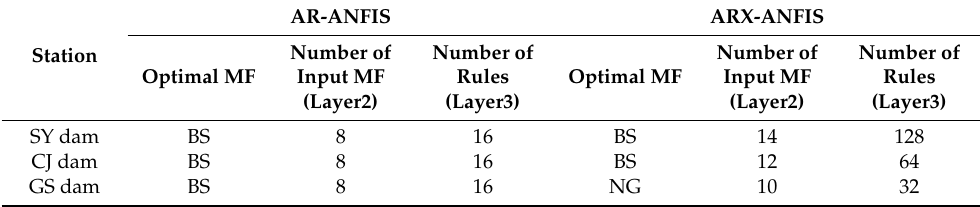
Figure 9. Correlation coefficients ( r ) and root mean square error (RMSE) of the AR-ANFIS and ARX-ANFIS models according to the MF in the validation period for the SY, CJ, and GS dams. The NS is normalized Gaussian MF and the BS is the Bell-shaped MF. The blue line is the r-value in the validation period and the red line is the RMSE in the validation period. Table 7. A number of input MFs and rules of the AR-ANFIS and ARX-ANFIS models for the three